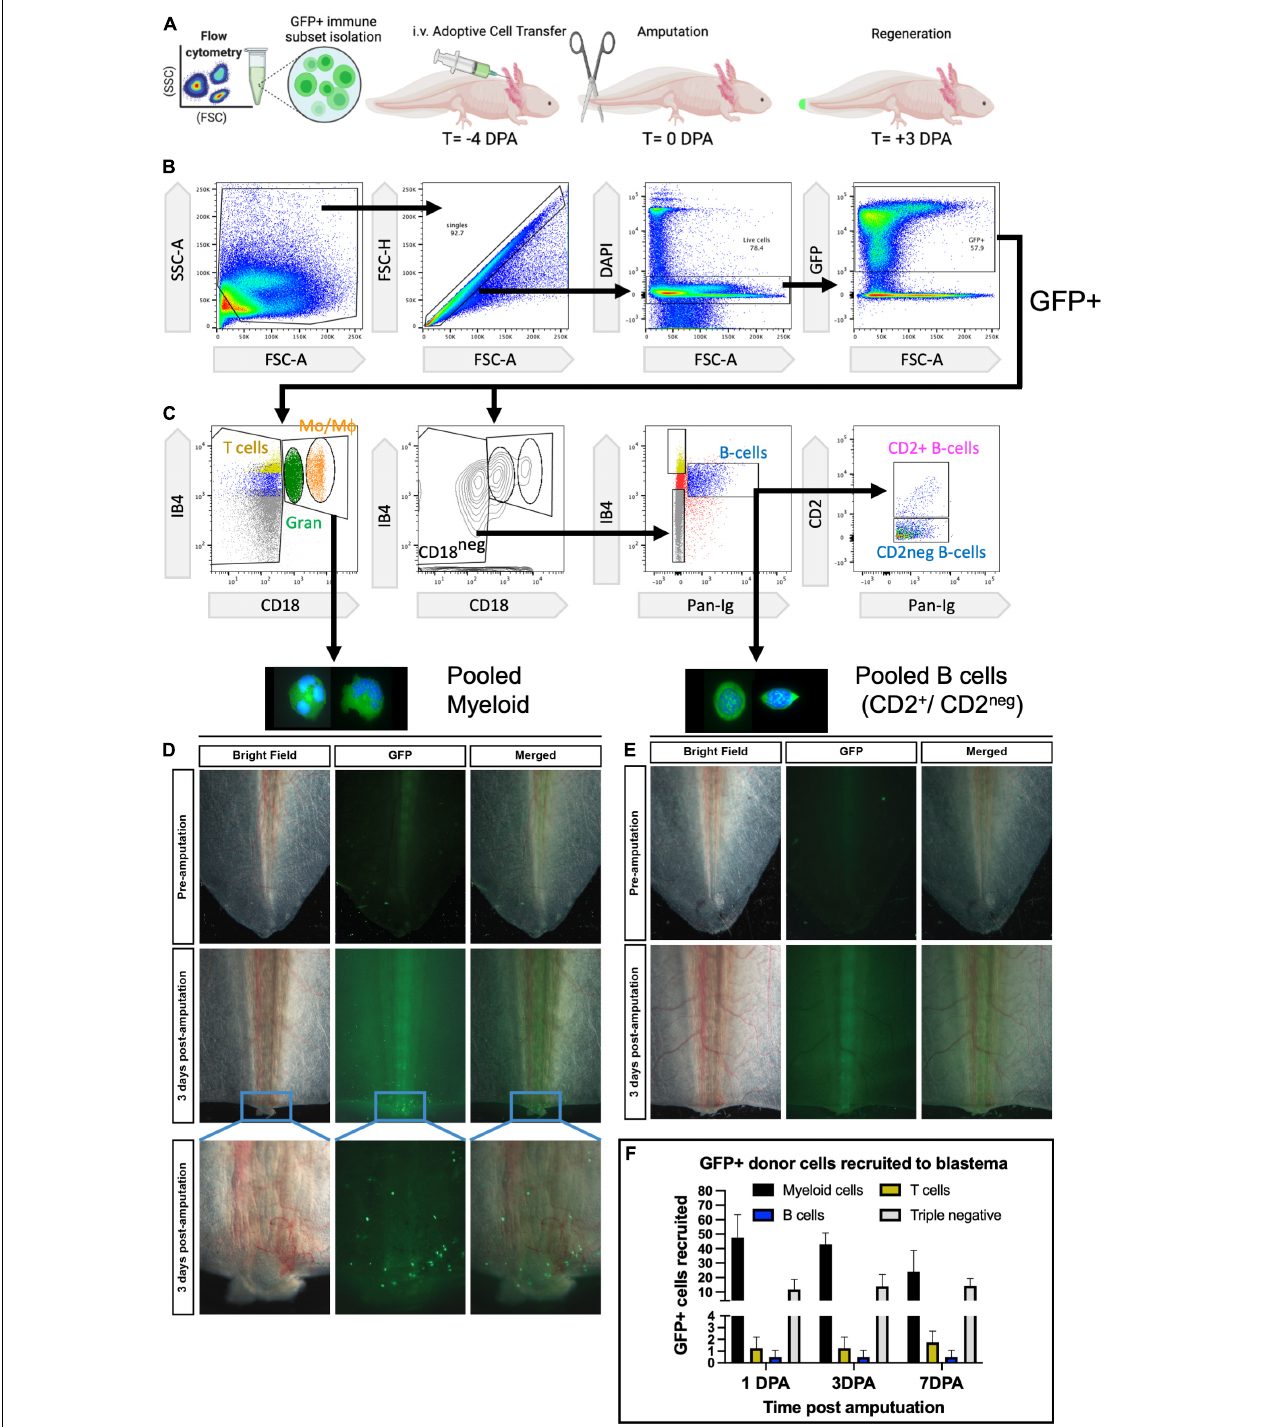
FIGURE 2 | Myeloid cells are the major circulating leukocytes recruited to early wounds. (A) Experimental design to test peripheral blood recruitment to wounds. FACS isolation of peripheral blood leukocytes obtained from transgenic Tg:CAGGS:GFP (ubiquitous GFP + axolotls) and adoptive transfer of 5 × 10 4 GFP + donor cells before tail amputation and live cell imaging at 3 dpa. (B,C) FACS gating strategy for isolation of viable single cells and collection of myeloid cells and B lymphocytes. (D) Representative images show that myeloid cells are consistently detected in early 3-day wounds of amputated tails. (E) No detectable recruitment of GFP + Pan-Ig + B cells is observed in 3-day wounds of amputated tails. N = 4 host recipients per transplant group. (F) Recruitment of major leukocyte cell types quantified at 1, 3, and 7 dpa. DPA, days post amputation.